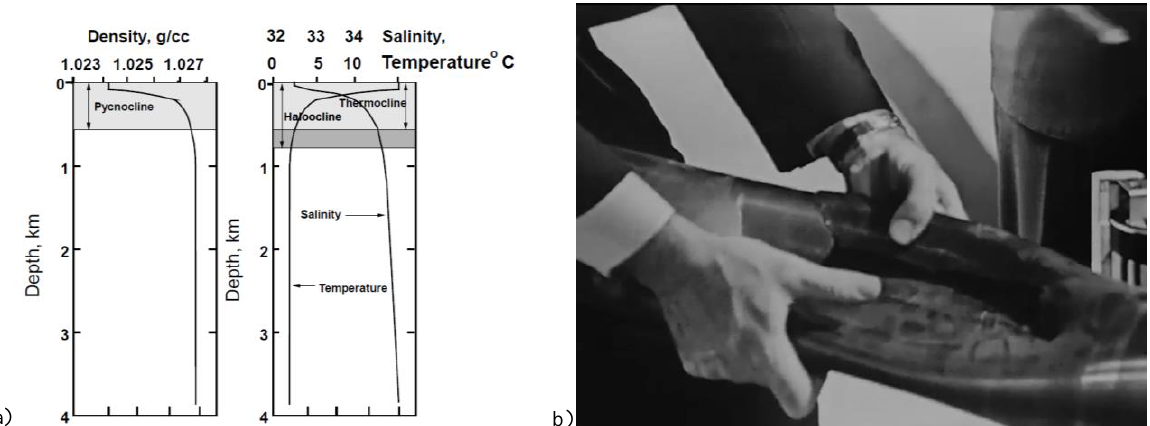
Figure 1. (a) Water density, salinity and temperature variation with depth (Ocean Stanford Edu). (b) Effect of pressure at high depth: Steel waterproof camera housing collapsed at a depth of about 6000 m (frame extracted from